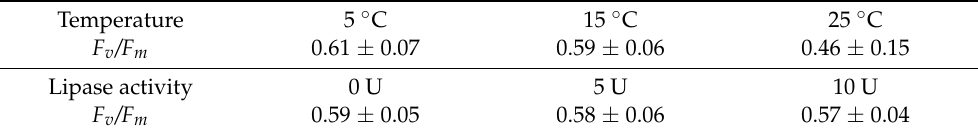
Table 1. F v /F m parameter, determined from fast Chl a fluorescence induction transient measurements, of granum thylakoid membranes at different, gradually elevated temperatures and after treating the membranes with different activities of wheat germ lipase; errors represent standard deviation from four batches. Temperature 5 ◦ C 15 ◦ C